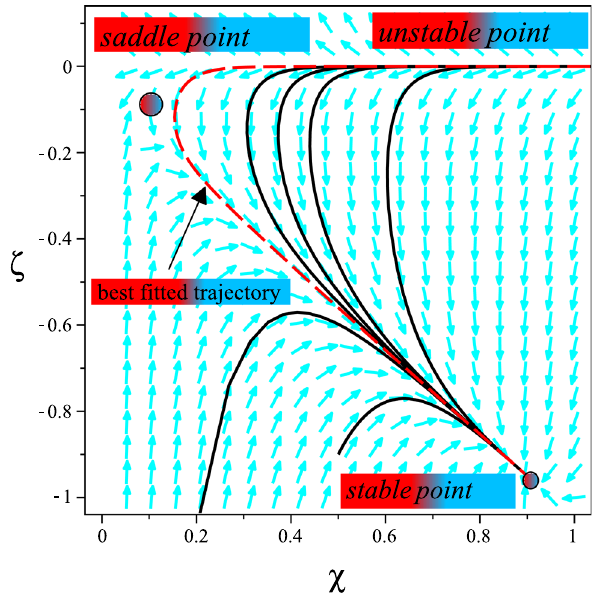
Fig. 5 The two dimensional phase plane for ζ,χ . The trajectories entering the best fitted stable critical points with the model parameters α and c are shown by black lines. The red dash trajectory approaching the stable point corresponds to the best fitted stability parameter and initial conditions